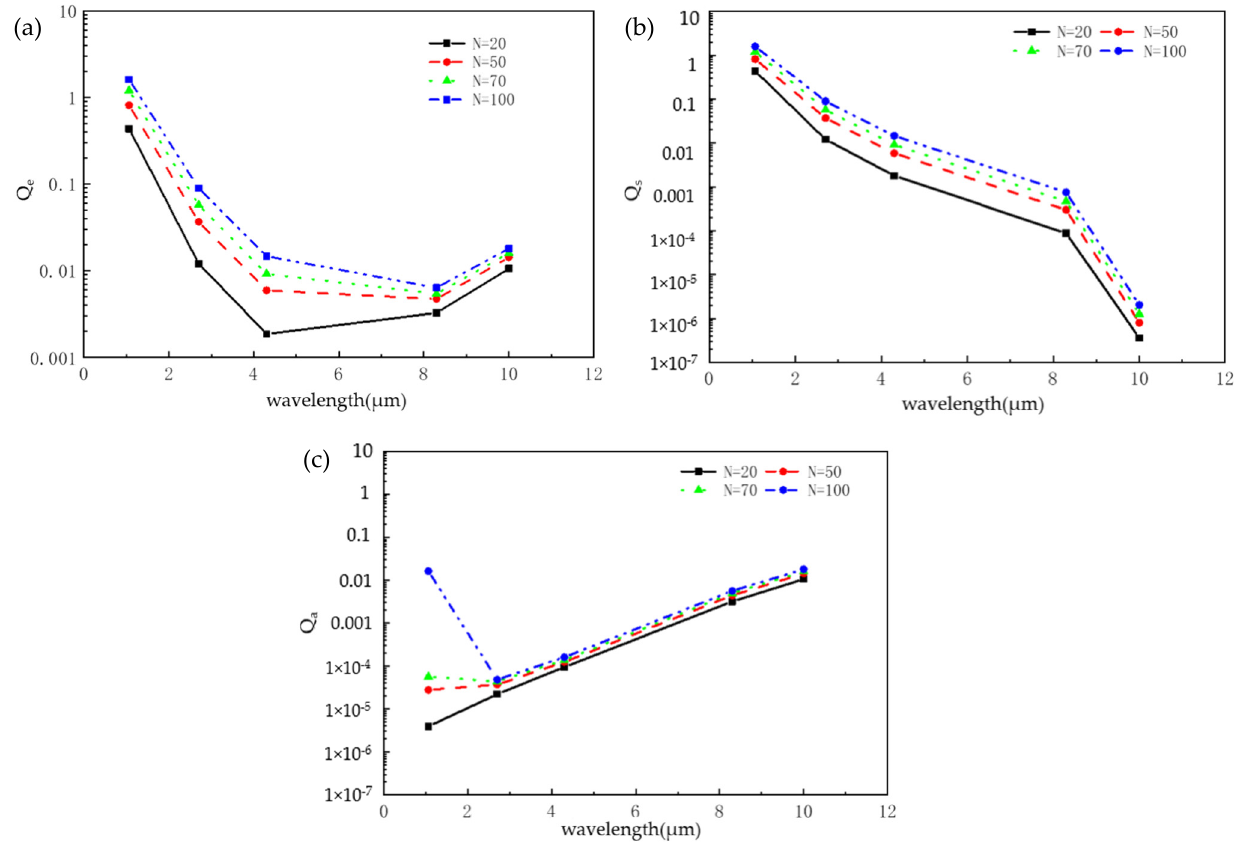
Figure 8. The radiation properties of SiC clusters with different sizes at different wavelengths: ( a ) extinction factor (Q e ); ( b ) scattering factor (Q s ); ( c ) absorption factor (Q a ).